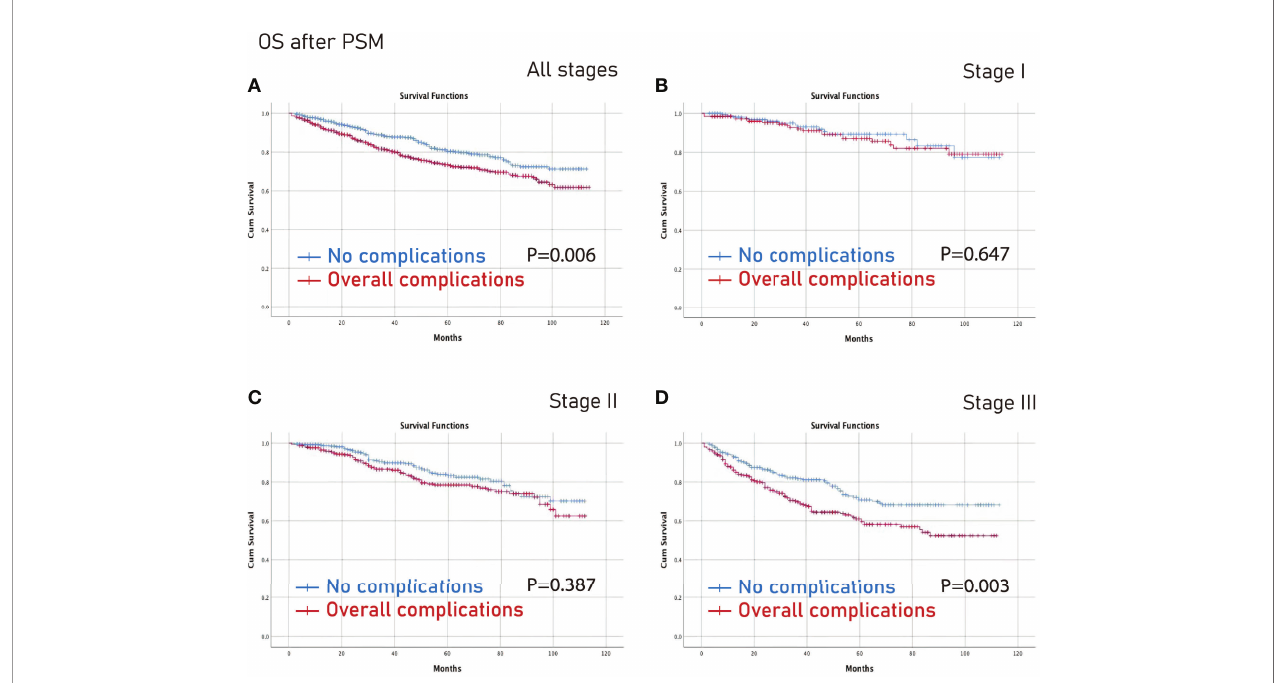
FIGURE 3 | OS between the no complications group and the overall complications group after PSM. (A) , all stages; (B) , stage I; (C) , stage II; (D) , stage III. OS, overall survival; PSM, propensity score matching.